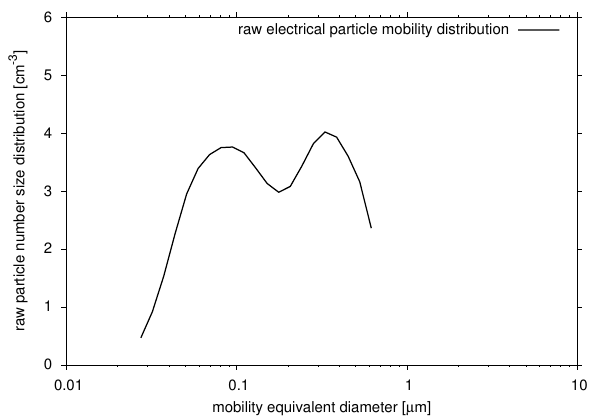
Fig. 4b: Example of the error propagation of a mobility par- ticle size spectrometer PNSD, Hohenpeissenberg, 23.02.12, one-hour average 0:00 - 1:00, EPMD (black) in plain con- centration (secondary y-axis) and PNSD (red).. The relative error of the result is not significantly different from the input in case of Poisson counting statistic.